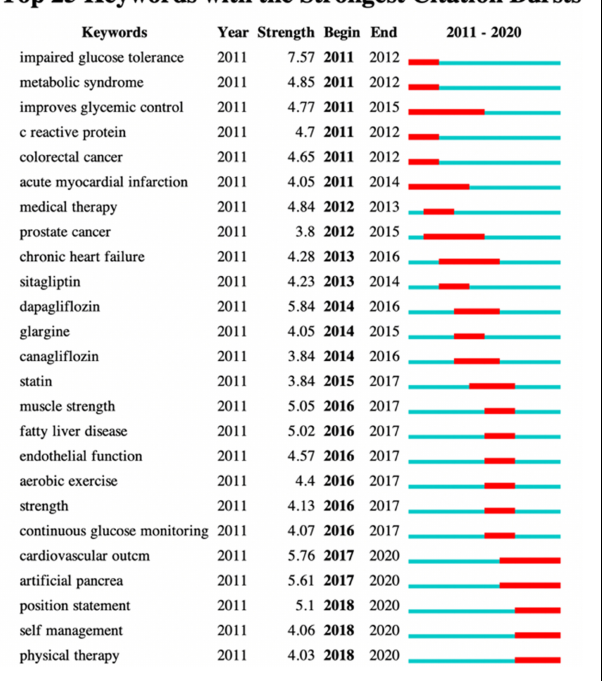
FIGURE 4 | Network map of keywords contributed to physical activity therapy for diabetes research. Each colored solid circle represents a country/region, and the lines between them represent collaborative relationships.